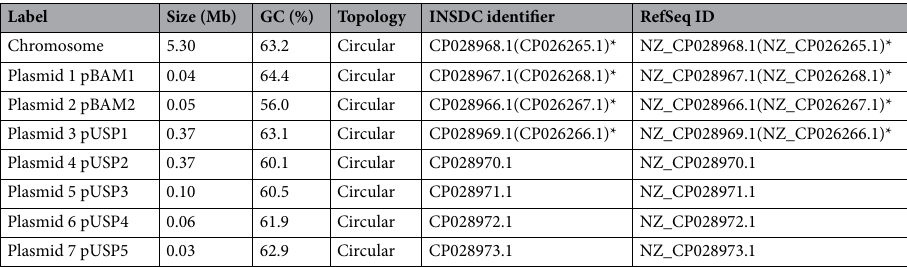
Table 1. Genome accession codes. *INSDC identifier and RefSeqID of KU Leuven substrain MK1 submission in brackets.